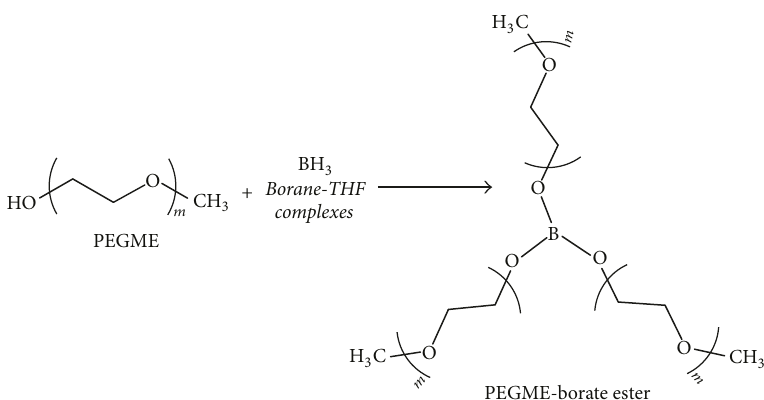
Figure 1: Synthesis scheme of PEGME-borate ester